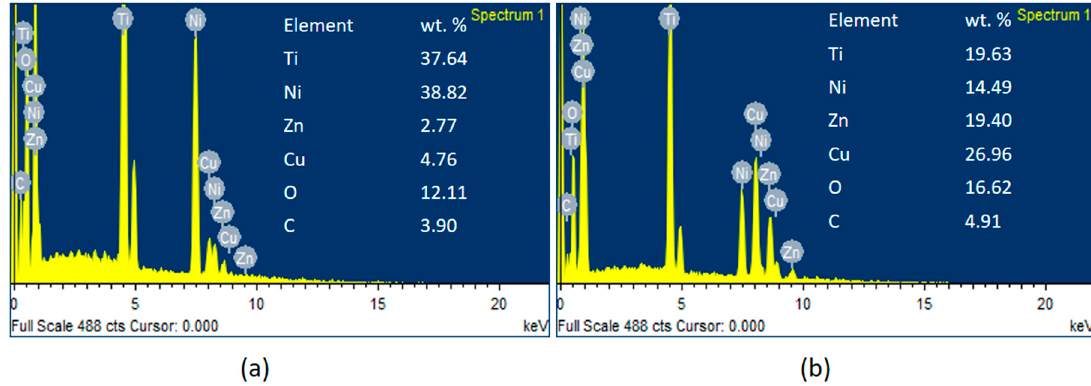
Figure 7. Energy dispersive X-ray spectrography (EDS) analysis for lower and higher TWR: ( a ) EDS analysis for lower TWR. ( b ) EDS analysis for higher TWR.